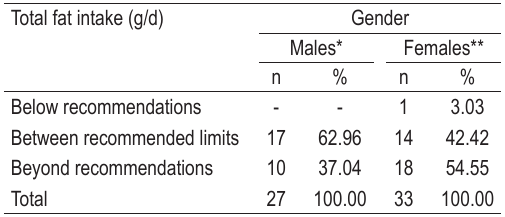
TABLE 4. Comparison dated total fat intake with recommendation by gender